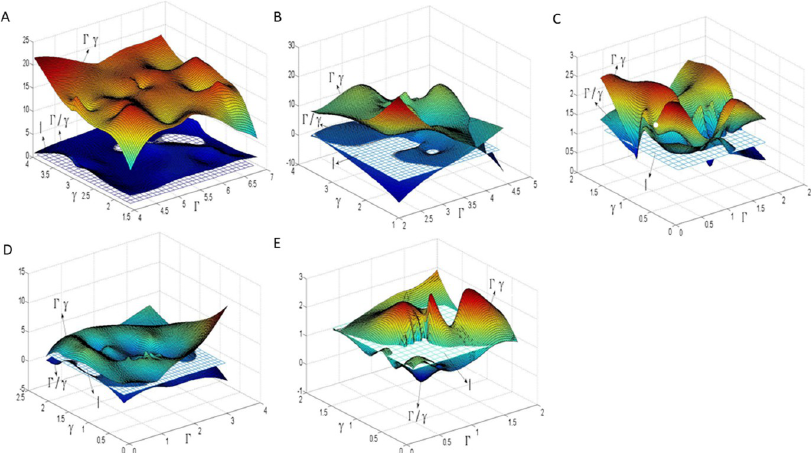
Fig 14. 3D fitted surface on the singular values and their relation of Jacobian matrix in parameterization on beetle model. (A) by LABF,(B) by LQHP, (C) by IQCP, (D) by QCTM, (E) by our method.